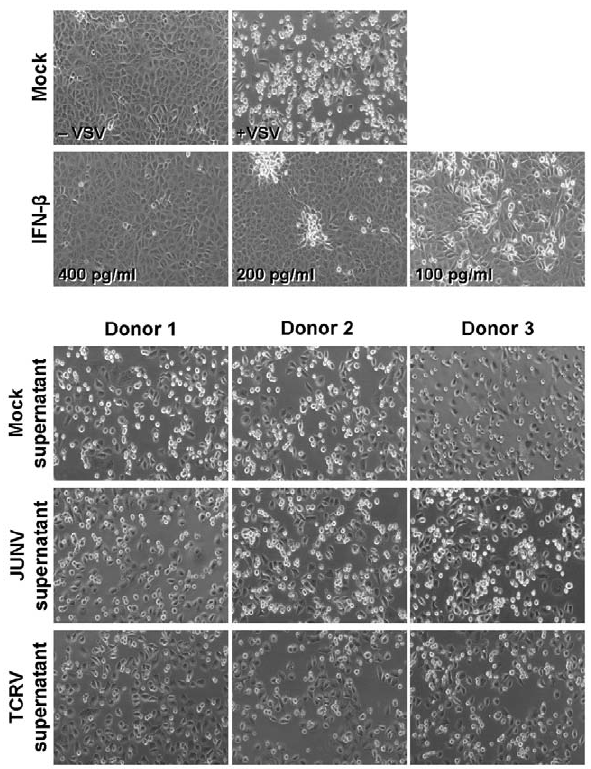
Figure 4. Bioassay for IFN production during TCRV and JUNV infection of primary human monocytes. IFN- a / b activity in monocyte culture supernatants was detected using a biological assay for protection against vesicular stomatitis virus (VSV) infection and its associated cytopathic effects. For this assay, VeroE6 cells cultured in 12- well plates were treated with supernatants from monocytes infected with either JUNV or TCRV, supernatants from mock infected monocytes or dilutions of a commercial recombinant human IFN- b standard (50 ng/ml to 100 pg/ml). After 24 h the cells were washed and infected with VSV at an MOI of 0.001. Cells were then incubated at 37 u C for 18 h before being examined for the formation of CPE.